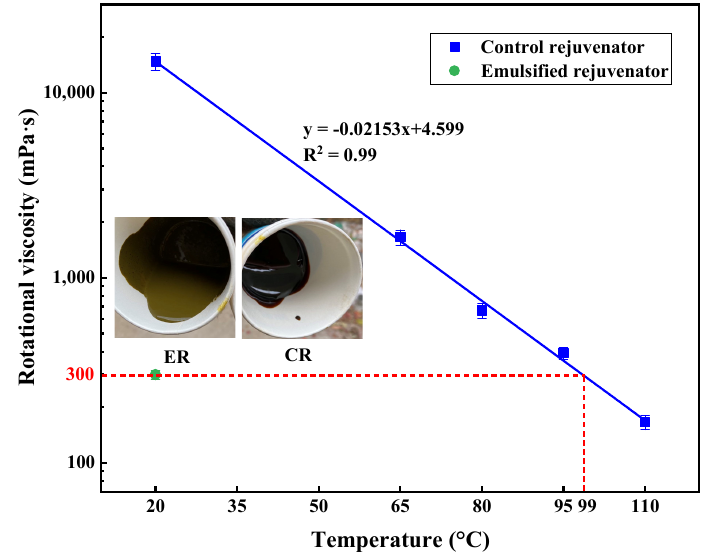
Figure 2. Rotational viscosity of ER and CR.